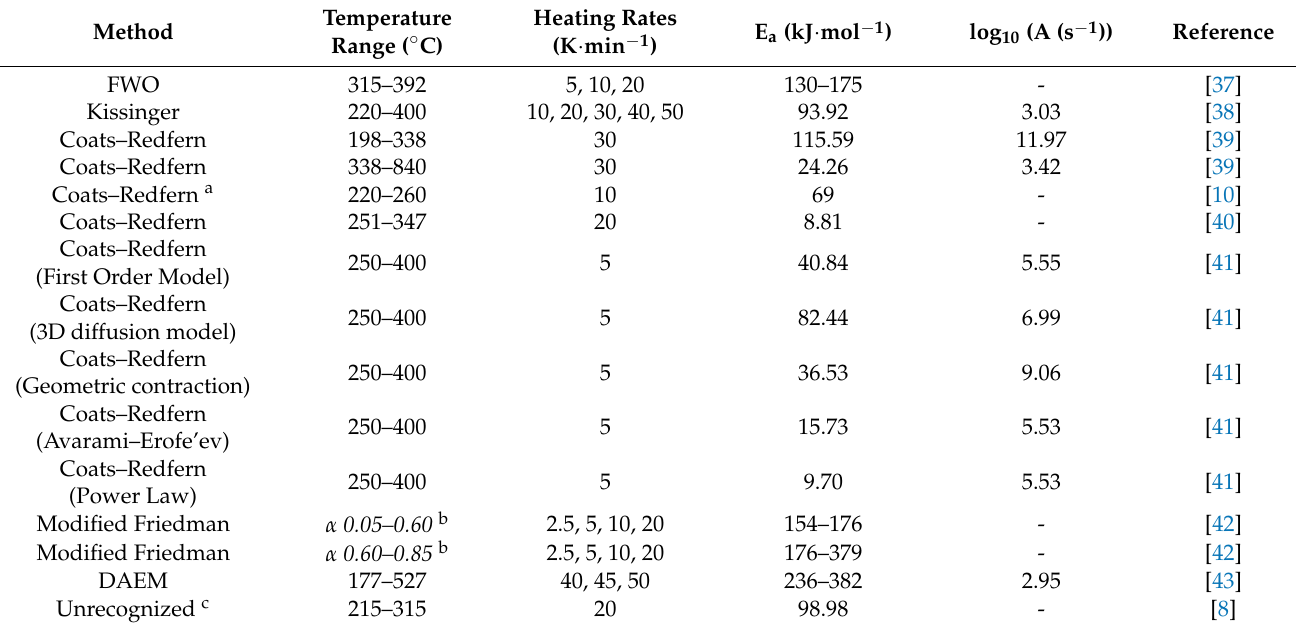
Table 2. Literature data of Arrhenius parameters for the non-catalytic degradation of wheat straw